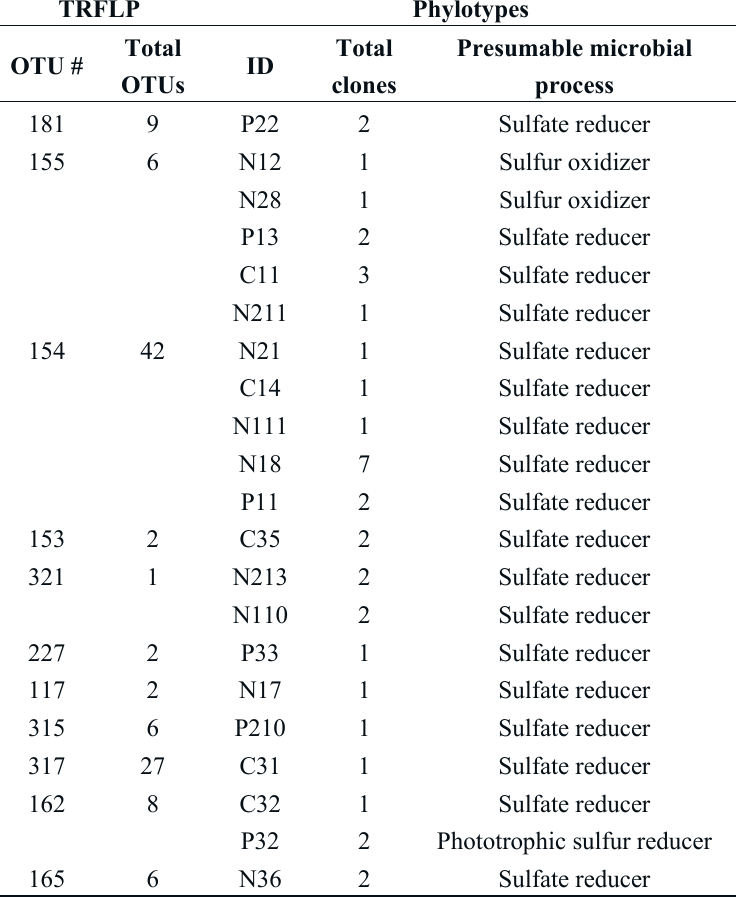
Table 3. Presumptive microbial processes of TRFLP-OTUs related with clone-OTUs. Similarity (%) based on amino acid sequences. Presumed microbial processes based on phylogenetic affiliation at the group level from the phylogenetic tree (Figure S1). Letters in the phylotypes ID refer to the nutrient treatment where the clone was found (control: Ctrl, phosphorus: P, and nitrogen: